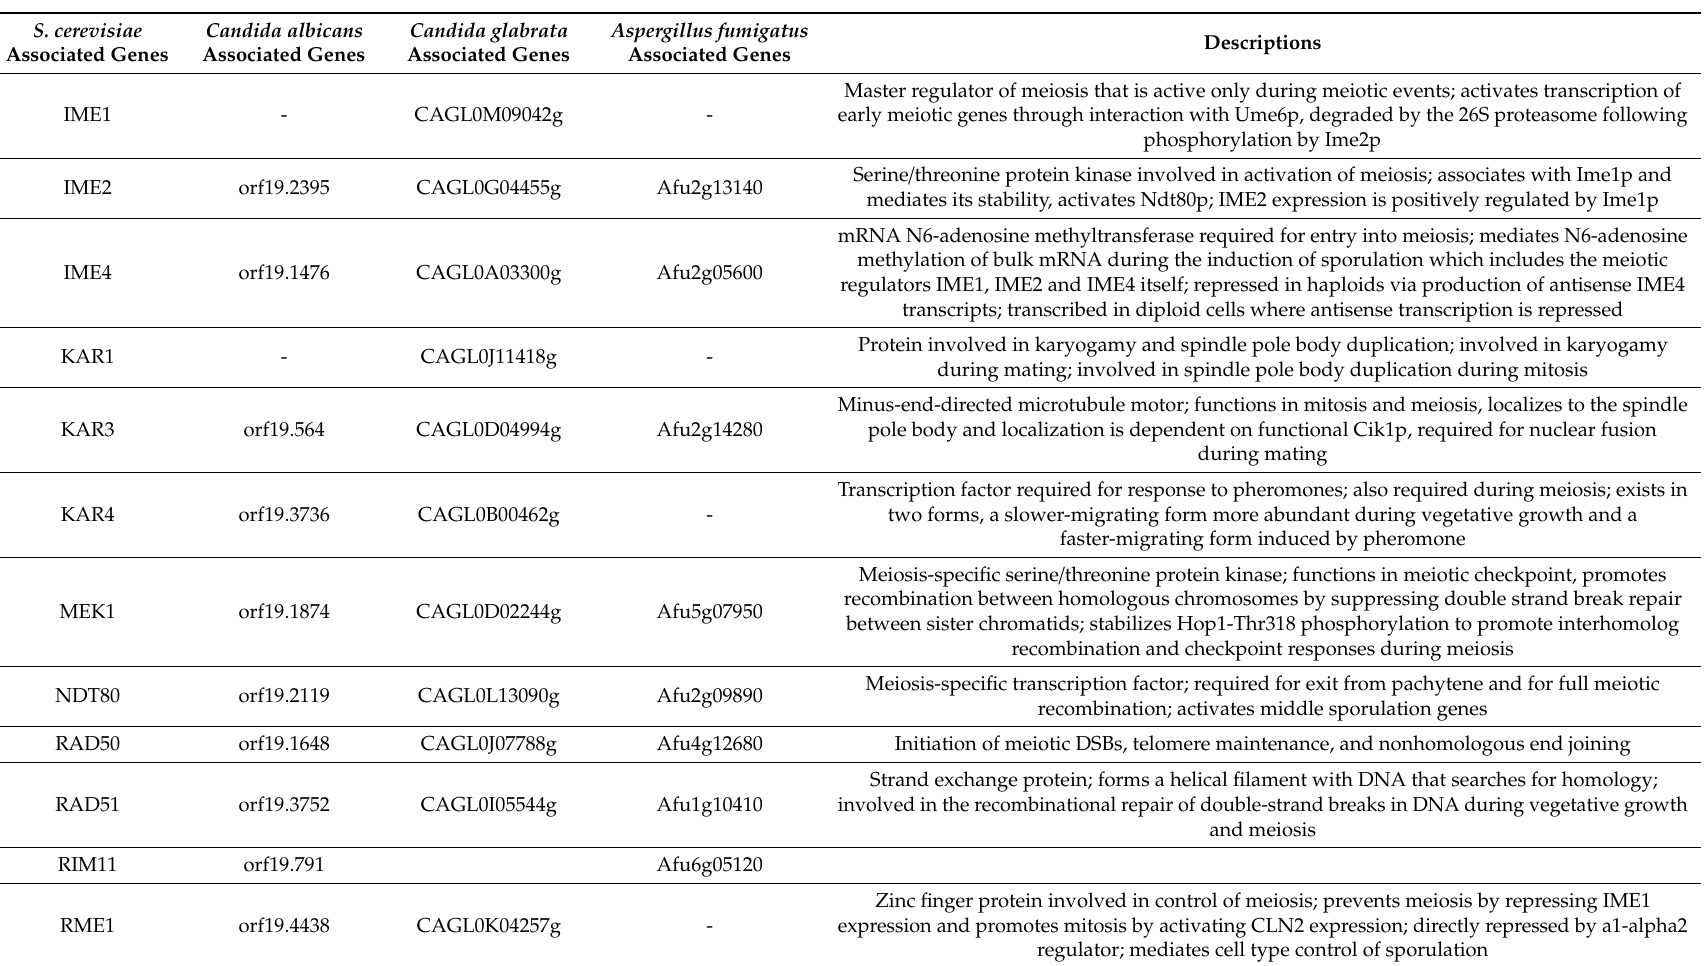
Table 1. List of genes involved in mating and